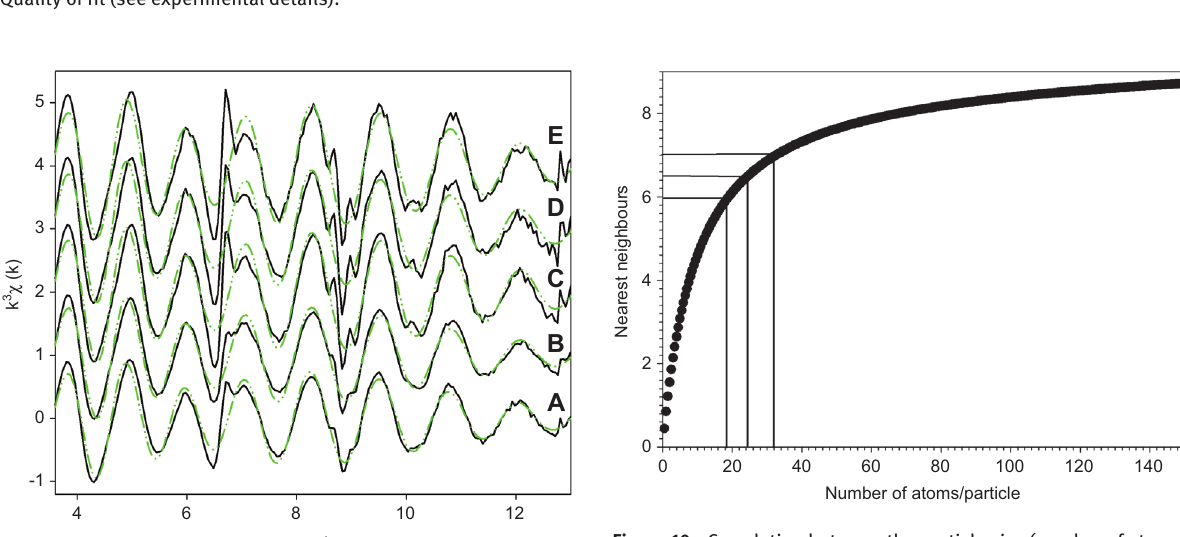
Figure 10 Correlation between the particle size (number of atoms) and the nearest neighbor coordination number.